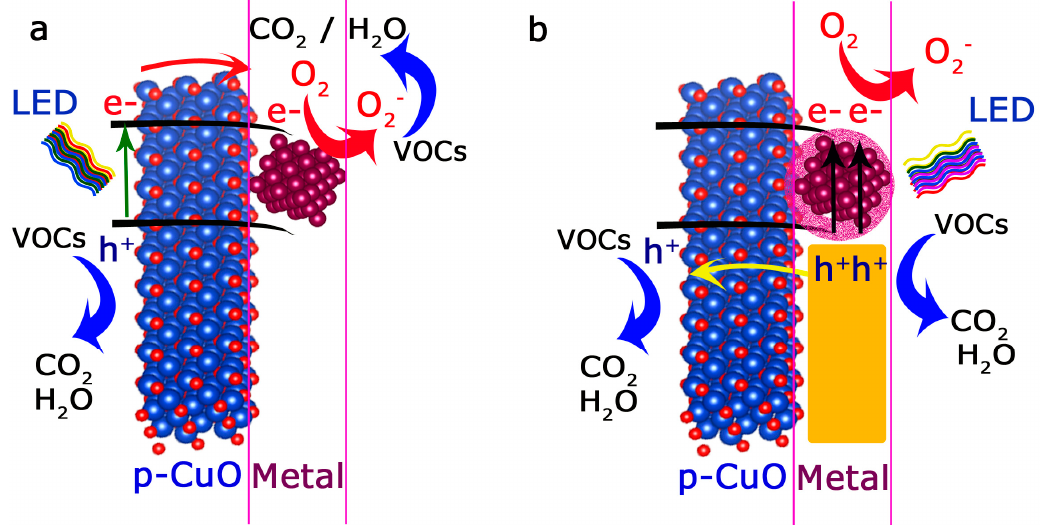
Figure 4. Schematic diagram illustrating the most plausible charge-transfer and photocatalytic mechanisms in the metal/p-type semiconductor Ag-CuO hybrids: ( a ) If the LED excitation wavelength is larger than the energy band gap of CuO, electrons from the valence band can be excited to the conduction of CuO and subsequently transferred and trapped by Ag energy levels; ( b ) Ag plasmon-induced charge transfer by hot holes injection into the p-type CuO energy levels.